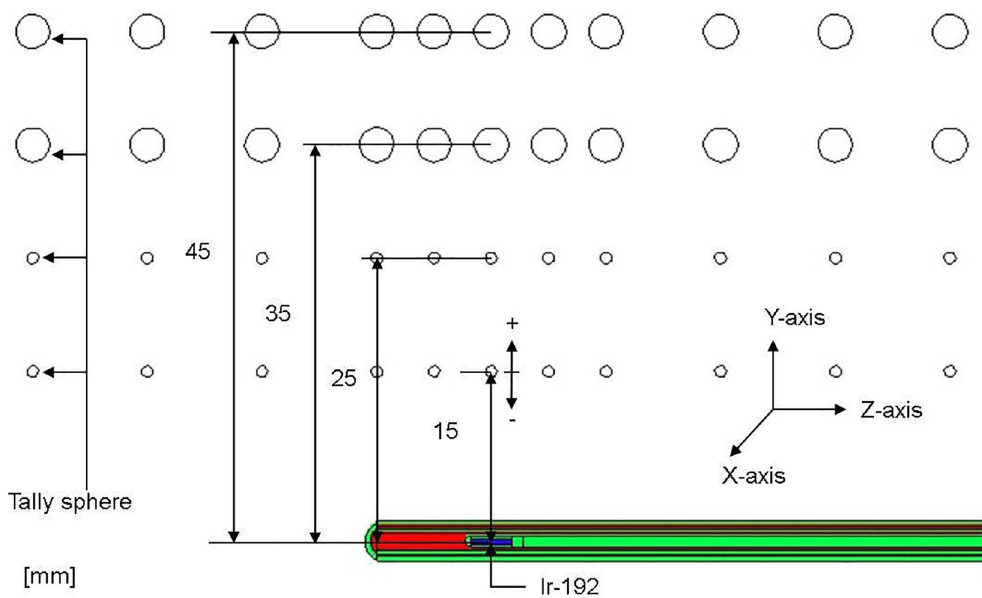
Figure 3. Diagram of the setup for simulating dose variation caused by imprecision of measurement-position MCNPX tally spheres are placed at different distances from the source. Positive/negative signs indicate positions away from or close to the source, respectively.